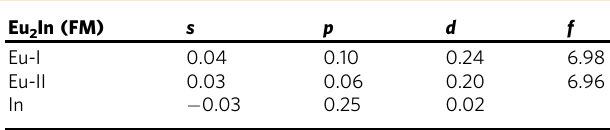
Table 1 Magnetic moments on the different orbitals